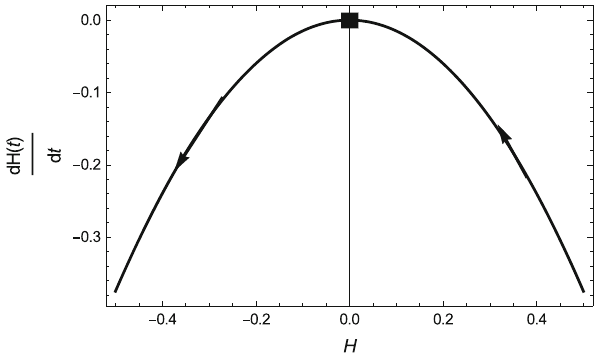
Fig. 16 Phase plot for ω = − 1. C 1 and C 2 are chosen to be